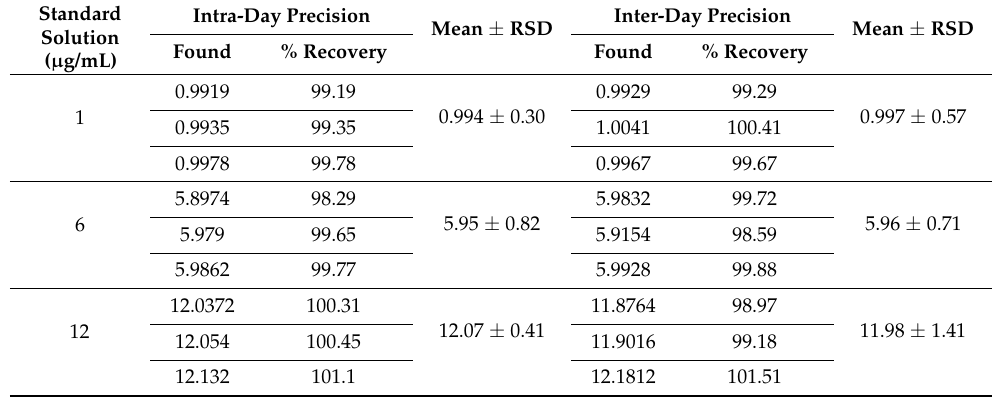
Table 3. The precision of the proposed HPLC method.